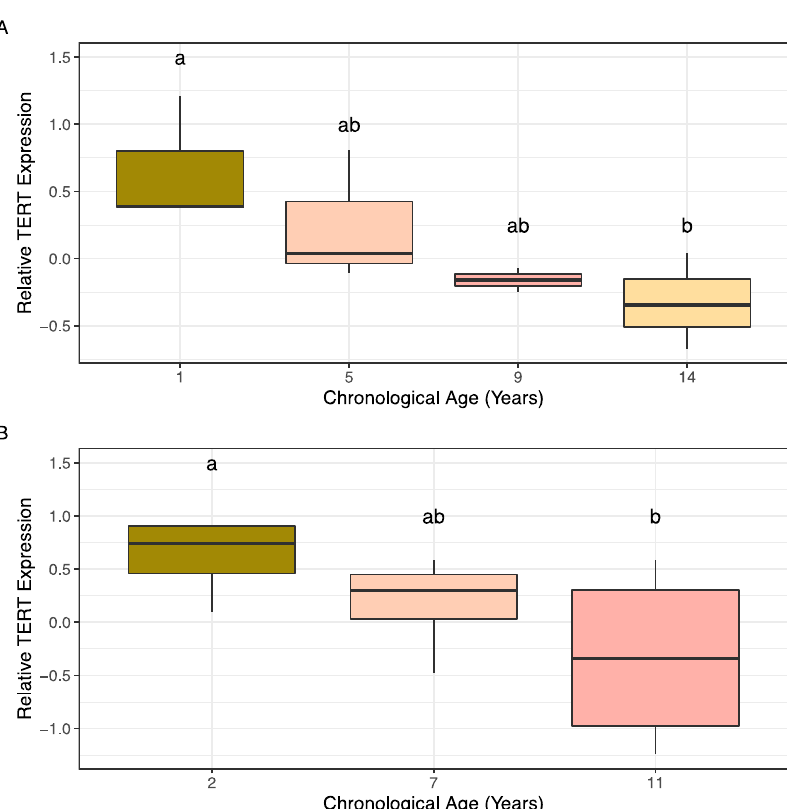
Figure 4. Normalized expression of TERT for almond samples within the age cohorts test. ( A ) Age cohort collected in 2018. ( B ) Age cohort collected in 2019. Significant differences in relative expression between age cohorts based on ANOVA followed by post hoc Tukey’s HSD (alpha = 0.1) are denoted by the letter groupings where differing letters indicate significant differences following means separation analysis (ANOVA 2018 p -value = 0.09087; ANOVA 2019 p -value = 0.1414) .